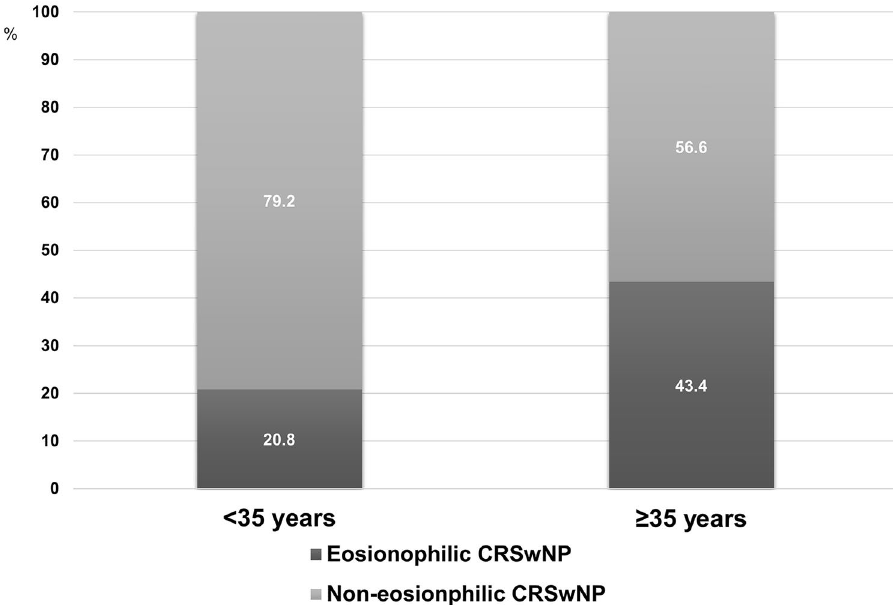
Figure 1. Distribution of eosinophilic and non-eosinophilic chronic rhinosinusitis with nasal polyp (CRSwNP) among younger (< 35 years) and older age groups (≥ 35